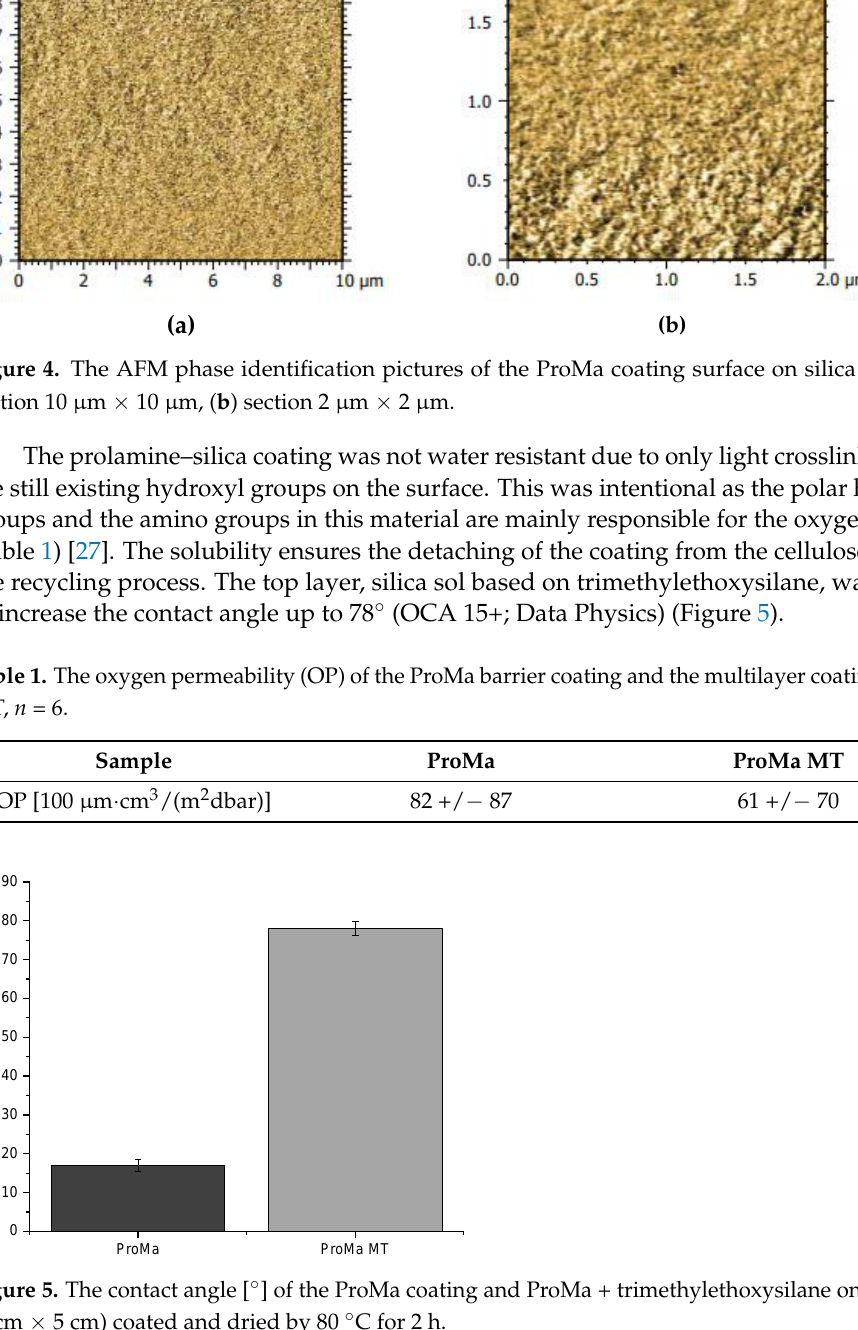
Figure 4. The AFM phase identification pictures of the ProMa coating surface on silica wafer ( a ) section 10 µm × 10 µm, (b ) section 2 µm × 2 µm.